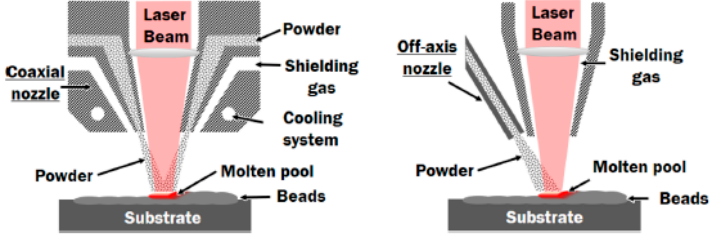
Figure 2. DED process illustration. Reproduced from [27]. Creative Commons CC BY